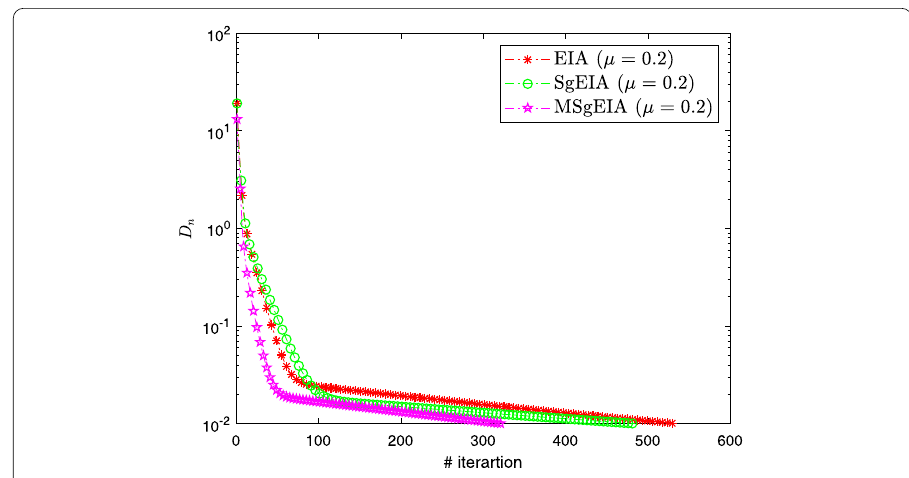
Figure 7 Experiment 5.2: Algorithm 2 compared in terms of iterations